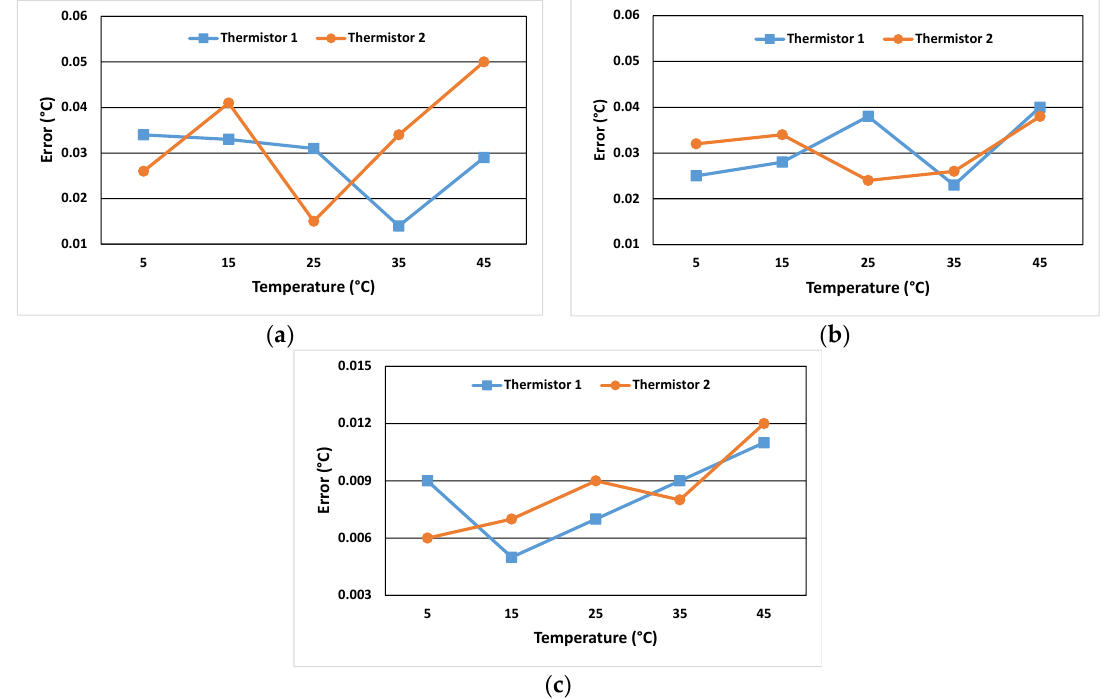
Figure 4. ( a ) Residual temperature offset of thermistors in the continuous temperature assessment; ( b ) residual temperature offset of thermistors in the step temperature assessment; ( c ) absolute values of errors between the two modes of temperature assessment.